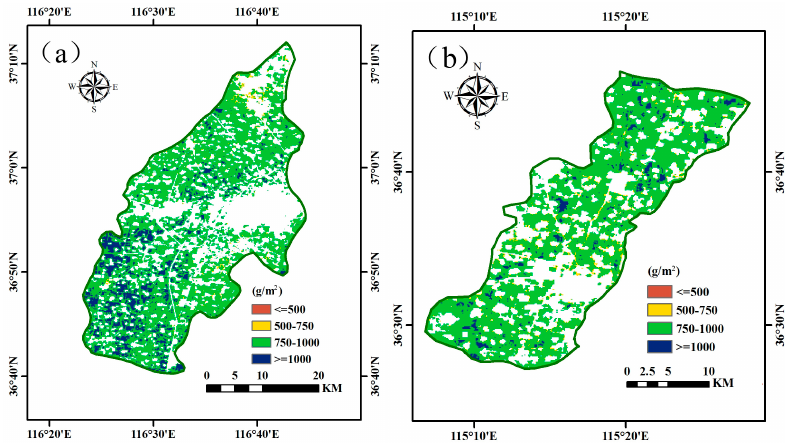
Figure 12. The estimated yield maps of the blended data: ( a ) Site 1; and ( b ) Site 2.